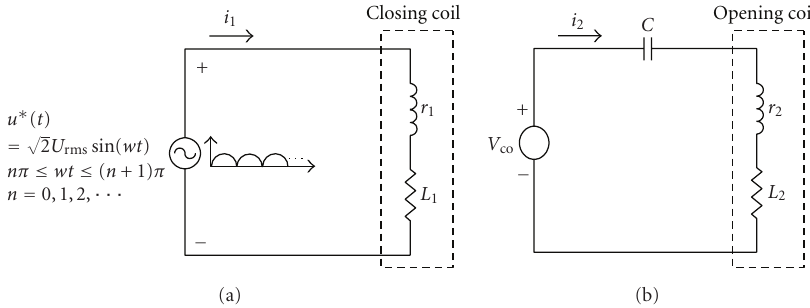
Figure 3: The equivalent electric circuit of AC PM contactor: (a) during the closing and holding process; (b) during the opening